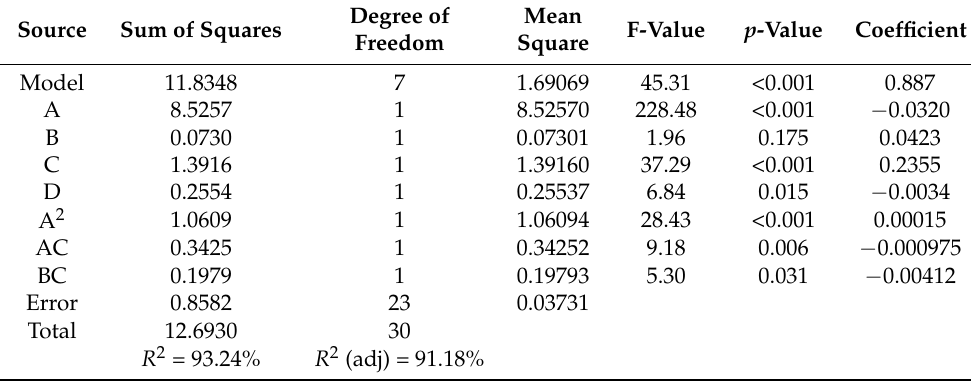
Table 5. The ANOVA of the reduced regression model for electrode wear ratio (EWR) of EDM with side flushing.